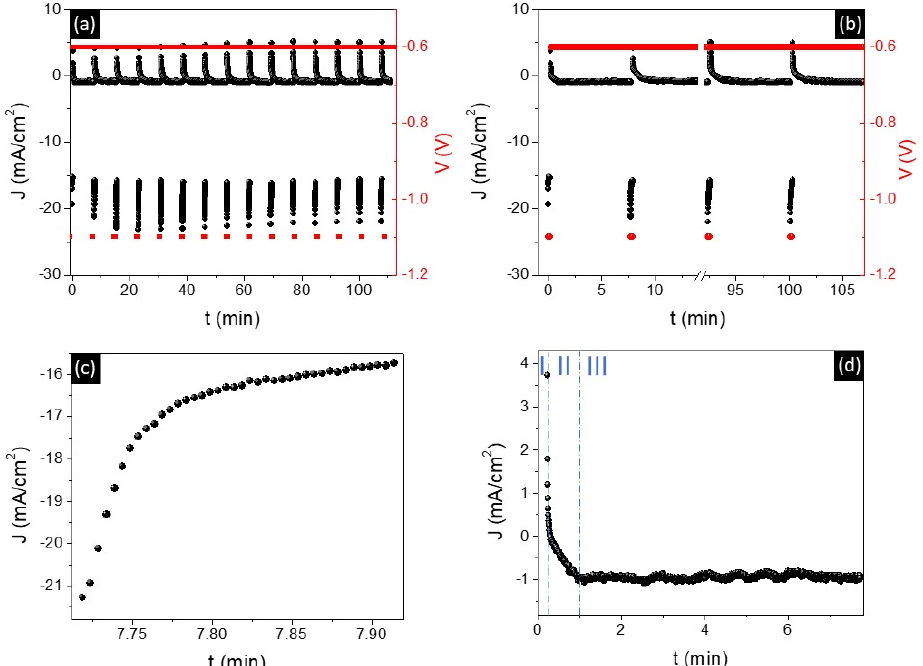
Figure 1. Current density transients of the pulsed electrodeposition process for the synthesis of the multi-segmented Fe/Cu nanowires (NWs) in anodic aluminum oxide (AAO) templates: ( a ) 15 Fe deposition pulses at − 1.1 V and 15 Cu deposition pulses at − 0.6 V. ( b ) Zoom of the first two and last two pulses of the Fe and Cu electrodeposition. Selected current density transients during the ( c ) Fe deposition and ( d ) Cu deposition processes.